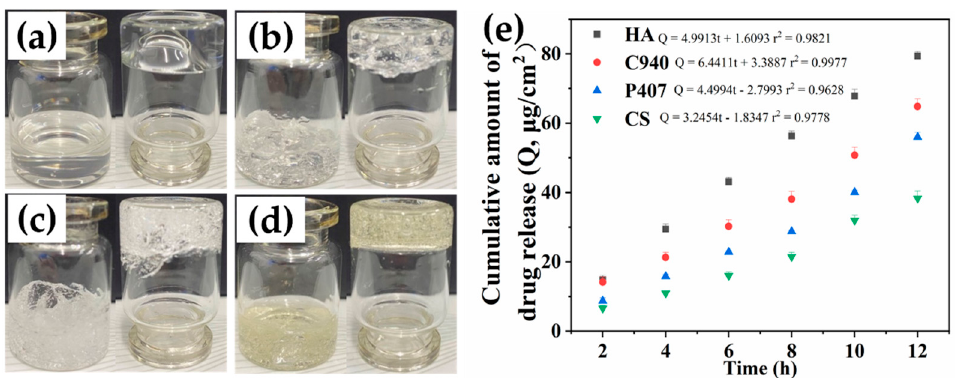
Figure 2. ( a – d ) Photographs of the blank hydrogel bases with different polymers, including ( a ) HA, ( b ) C940, ( c) P407, ( d ) CS; ( e ) effects of base types on the release of AA from the hydrogels.